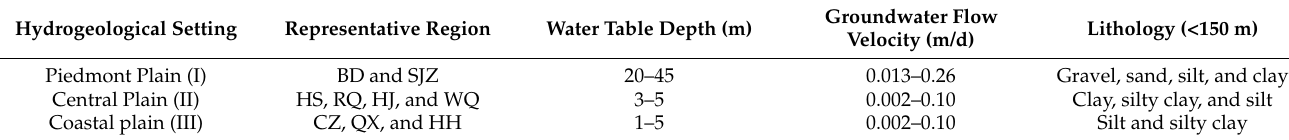
Table 1. General features of the representative regions.